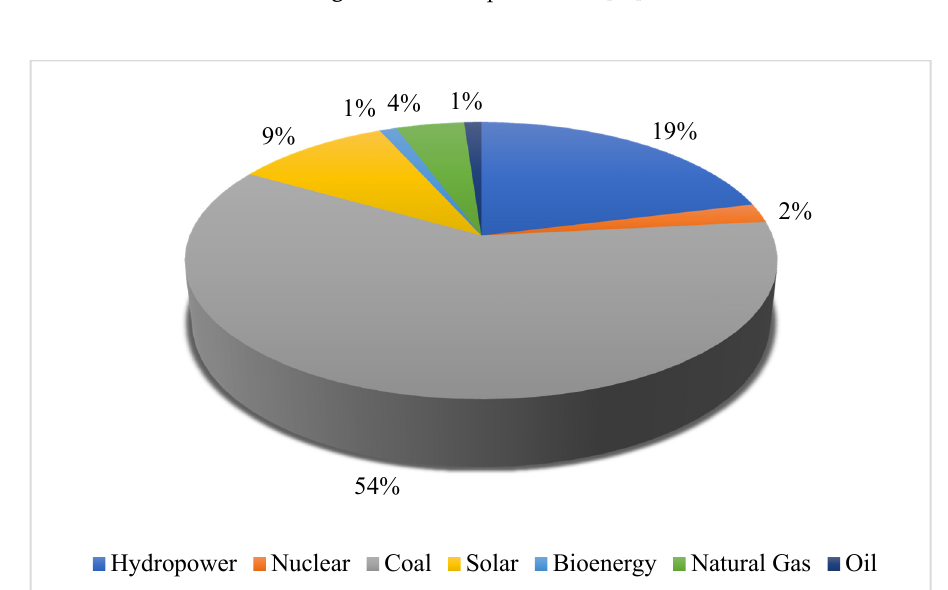
Figure 1. DNI map for China [35].